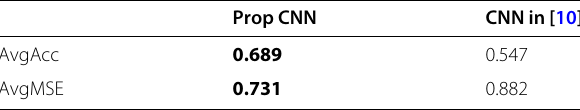
Table 1 Average performance of the proposed CNN estimator and [10] for QF 2 = 90